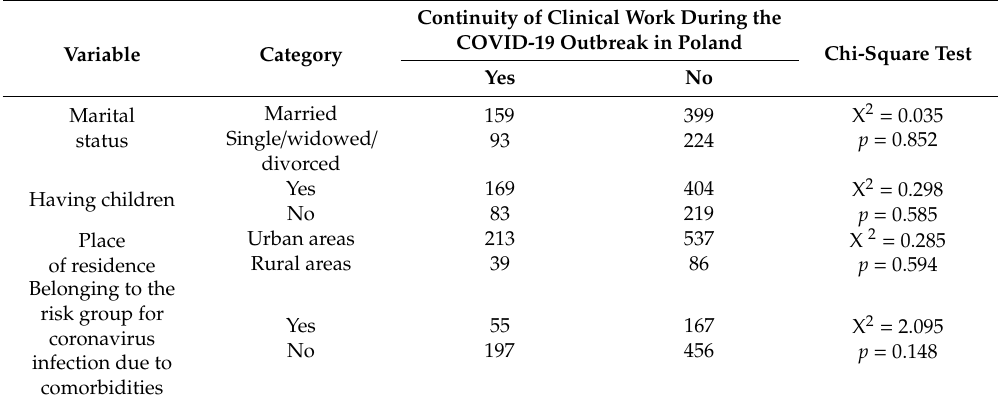
Table 6. Continuity of clinical work during the COVID-19 outbreak in Poland vs. marital status, having children, place of residence and belonging to the risk group for coronavirus infection due to comorbidities. Non-parametric statistical analysis, chi-square test ( p = 0.852; p = 0.585; p = 0.594; p = 0.148; p =